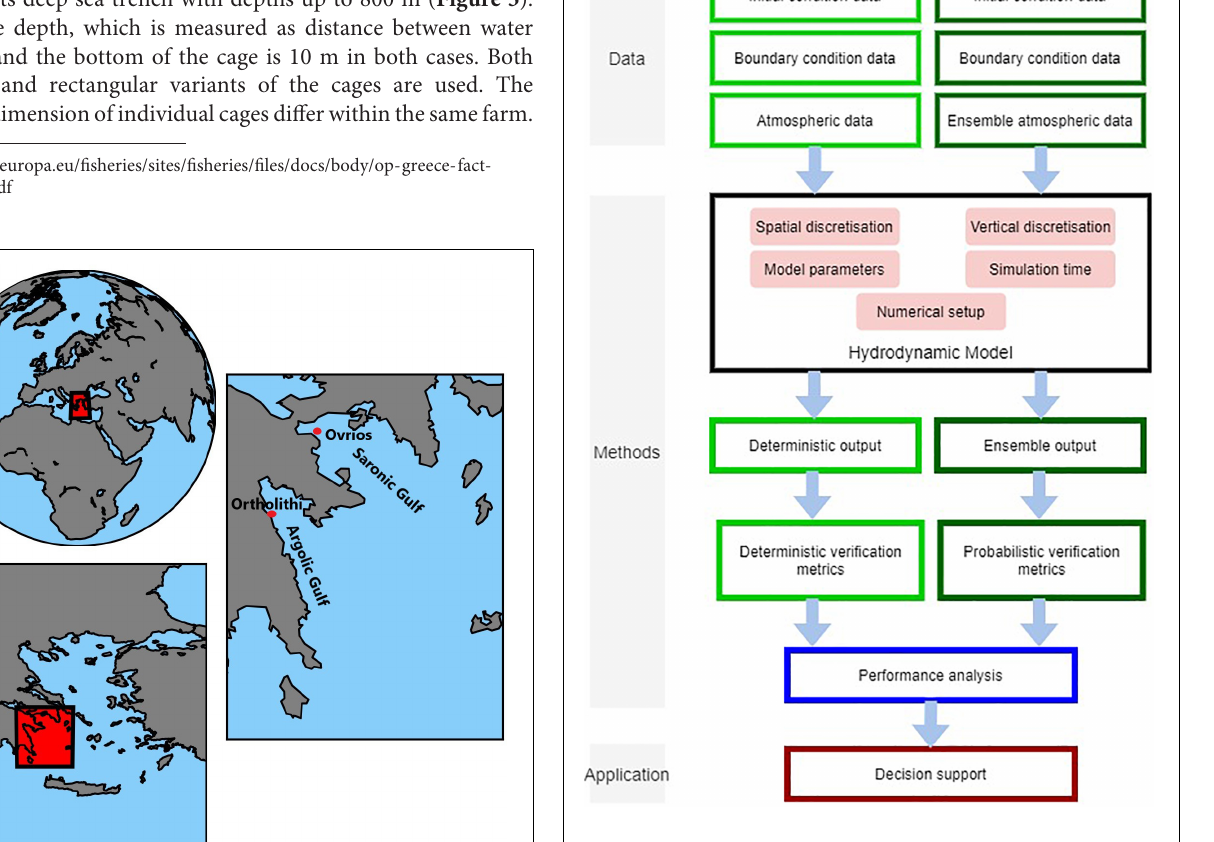
Frontiers in Marine Science |